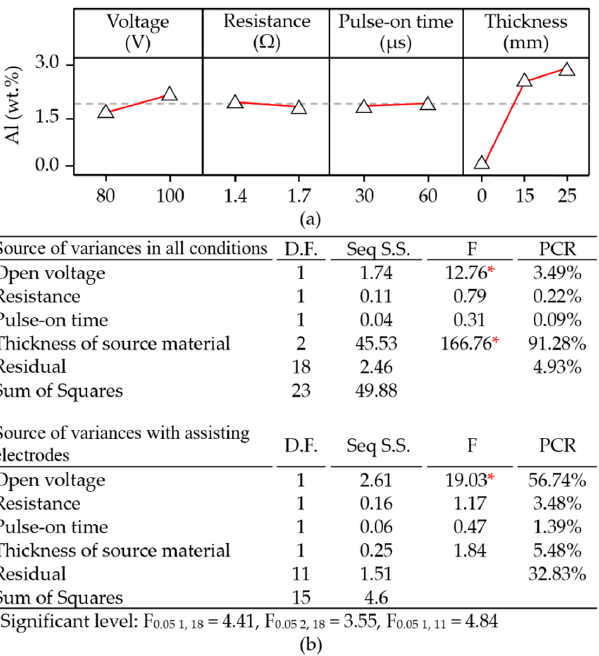
Figure 10. Statistical examination of main effect plots: ( a ) with operating parameter settings; ( b ) ANOVA results for deposition of aluminum on machined surface.